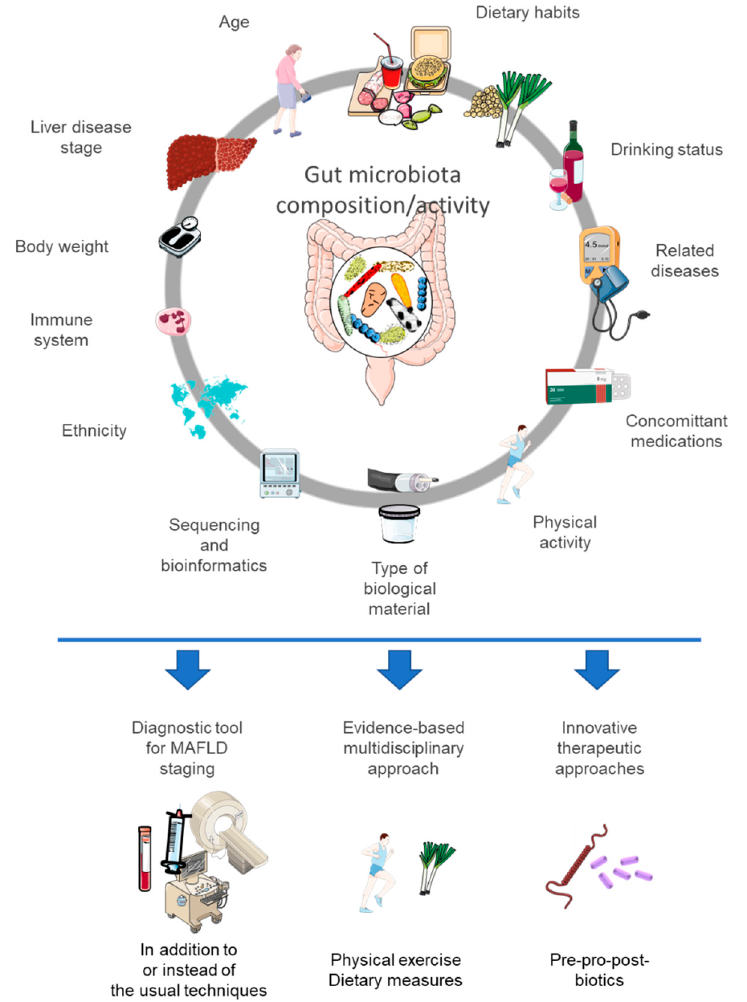
Figure 1. Many factors can influence the composition or activity of the gut microbiota, which can also be used or targeted in the assessment and management of metabolic dysfunction-associated fatty liver disease. This figure was partly created using Servier Medical Art templates (https://smart.servier.com) (accessed on 5 July 2022)